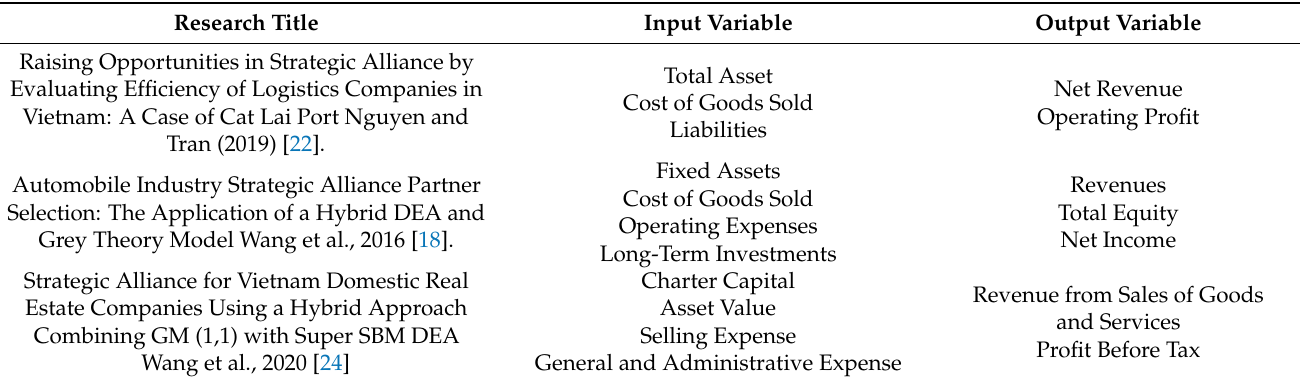
Table 1. Summary of input and output variables used in previous